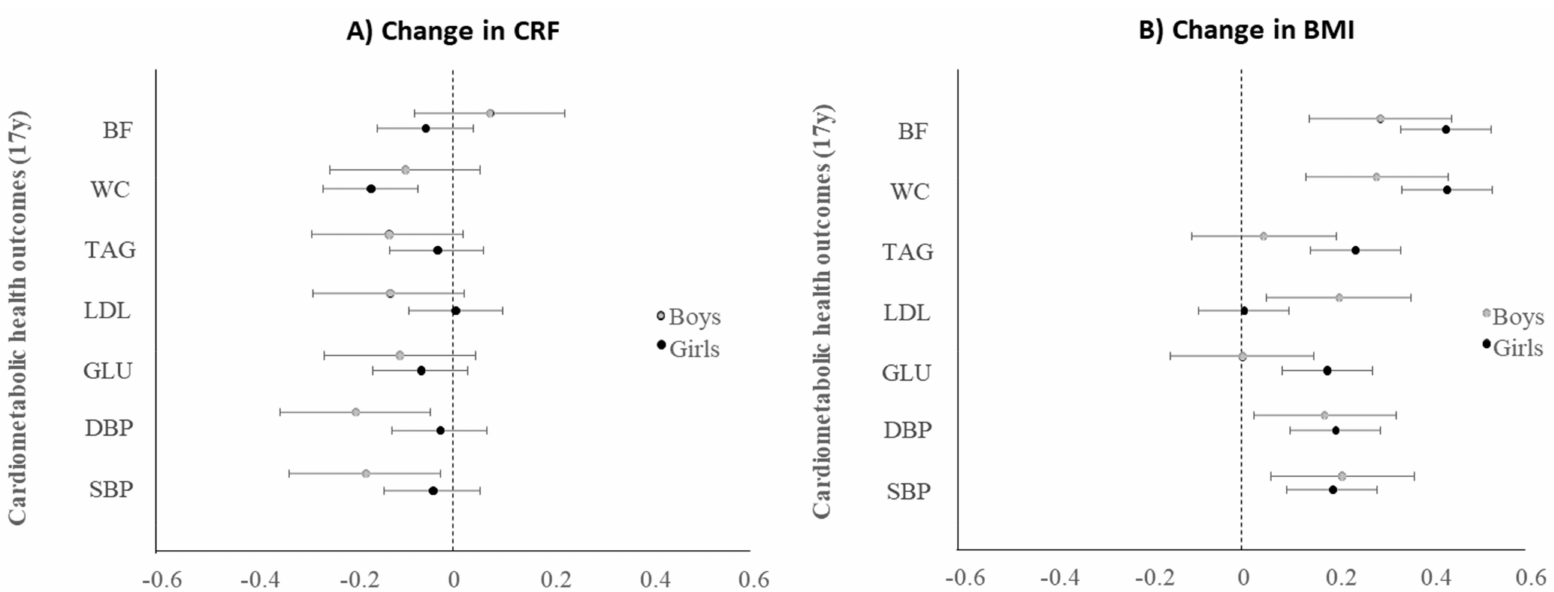
Figure 4. Associations between CRF and BMI trajectories (13 years–15 years) and cardiometabolic health outcomes at 17 years in boys and